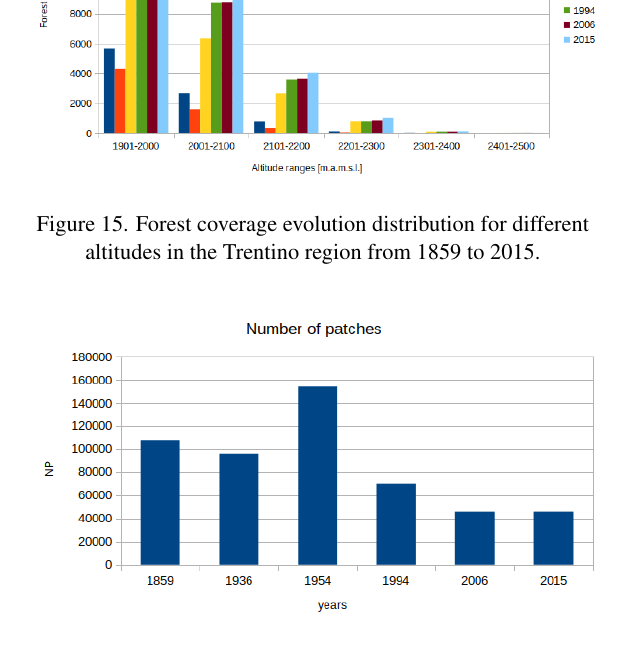
Figure 16. Number of forest patches change between 1859 and 2015.